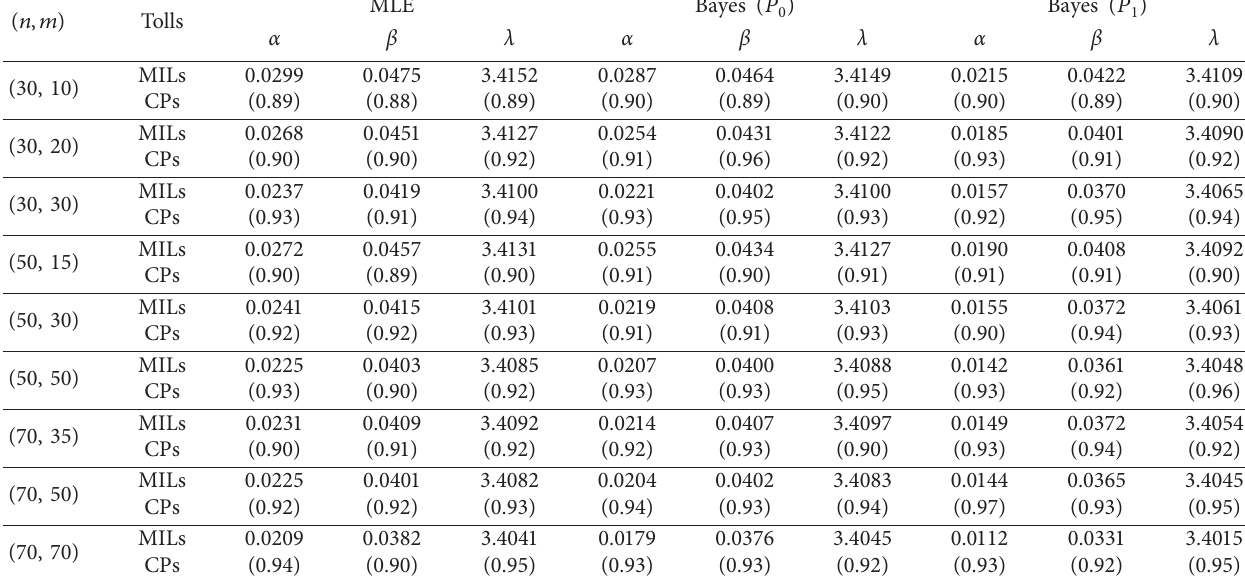
Table 5: MILs and CPs from ω � 0 . 01 , 0 . 02 , 1 . 5